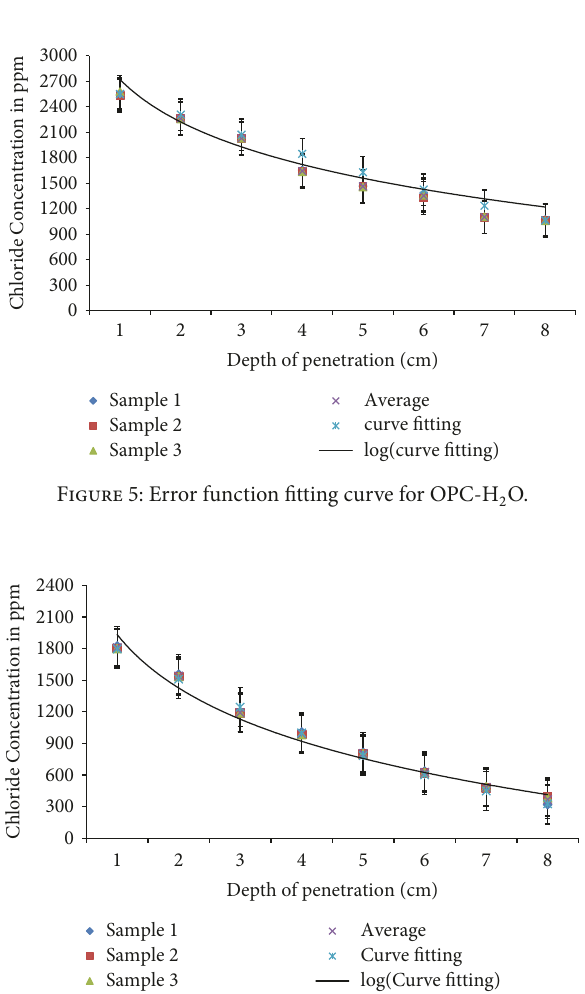
Figure 6: Error function fitting curve for PPC-H 2 O.